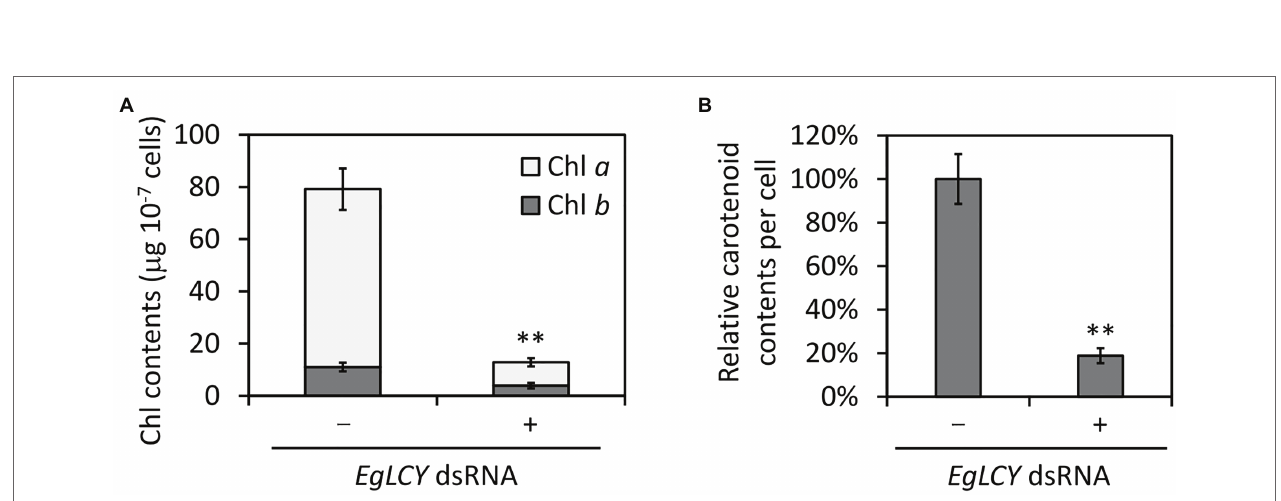
FIGURE 4 | Effects of EgLCY suppression on pigment content. Cells treated with or without EgLCY dsRNA were mixotrophically grown under continuous light (40 μ mol photons m − 2 s − 1 ) at 25 ° C for 6 d. (A) The chlorophyll (Chl) contents in cells treated with or without EgLCY dsRNA. (B) The relative total carotenoid contents of cells treated with or without EgLCY dsRNA. Values are presented as the mean ± SD ( n = 3). Values with asterisks are significantly different from cells treated without dsRNA according to the t -test (** p <